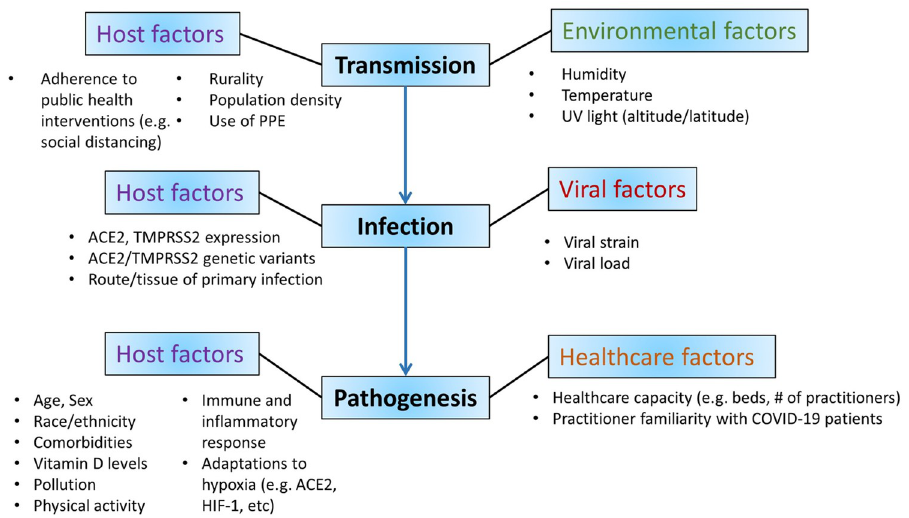
Fig 4. Summary of proposed mechanisms of difference in COVID-19 infection, transmission, and pathogenesis at high altitude. Factors which may impact COVID-19 infection and death at high altitude include host, environmental, viral, and healthcare